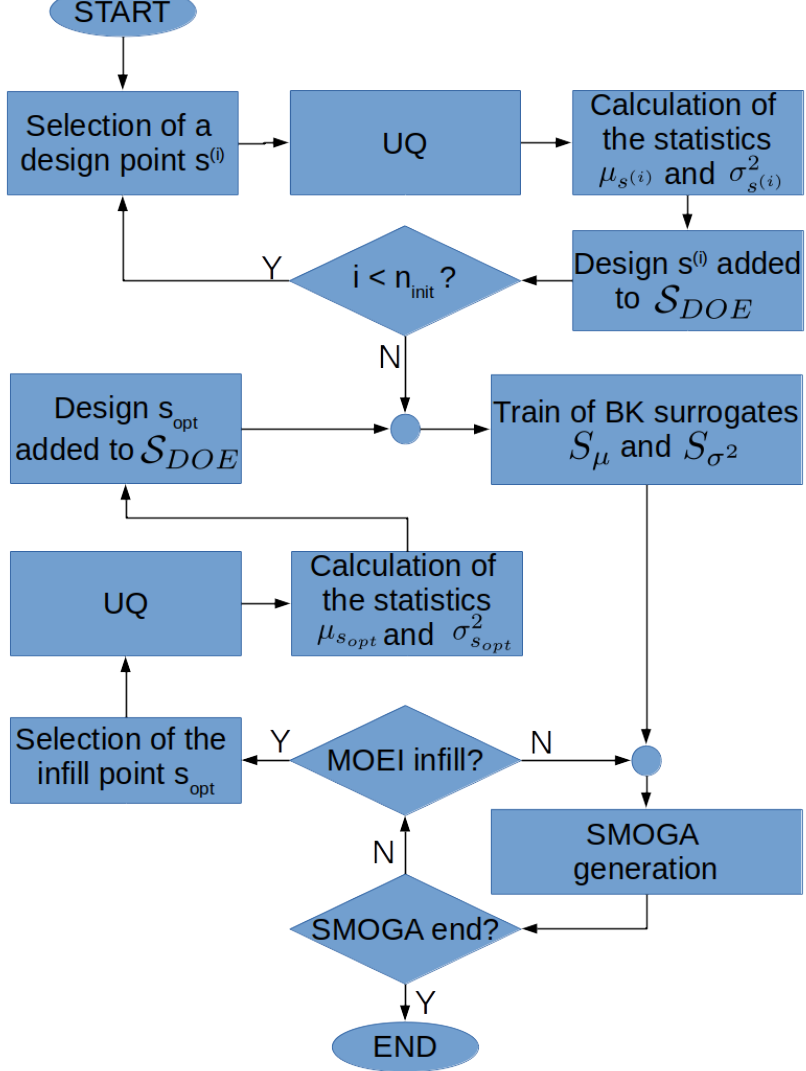
Figure 2. Flowchart of the BK-based SMOGA RDO